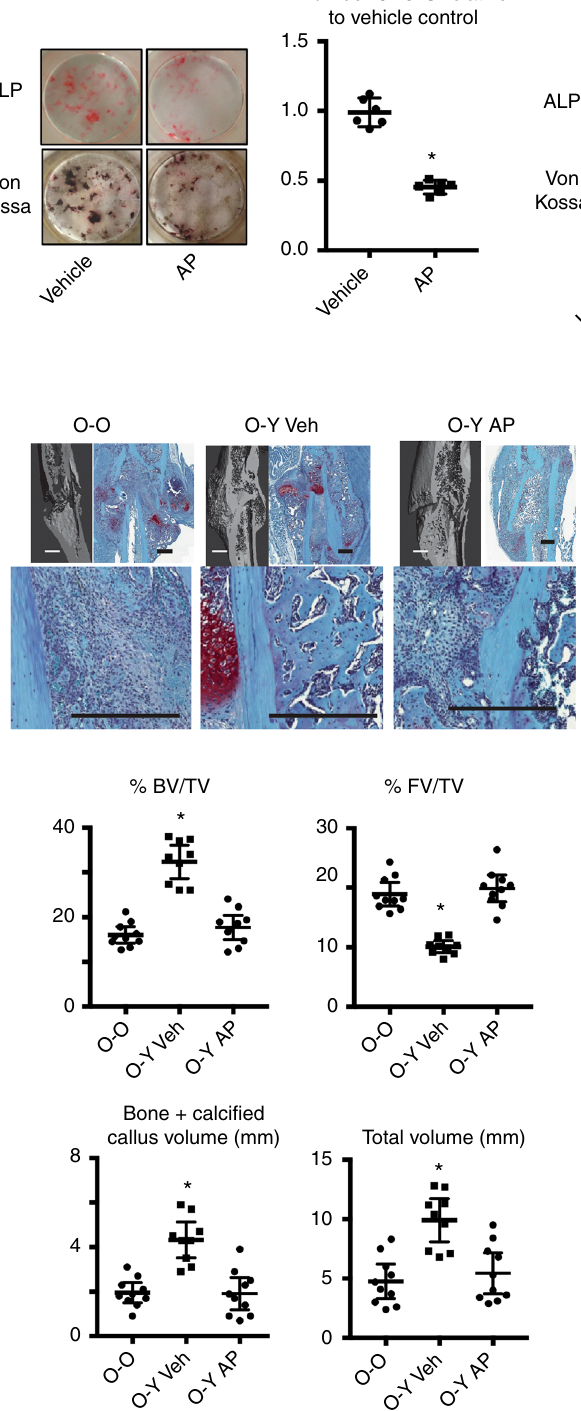
recapitulating the effects of aging on fracture healing. Yet, when these young animals were engrafted with old F4/80 − and young F4/80 + cells, they showed similar repair to animals engrafted with young F4/80 − and young F4/80 + cells (Fig. 2c). Taken together, these data indicate that macrophage cells regulate the pace of fracture repair. In old mice, young cells expressing F4/80 rejuvenate the repair process and aging of the F4/80 cell popu- lation will delay healing in the young